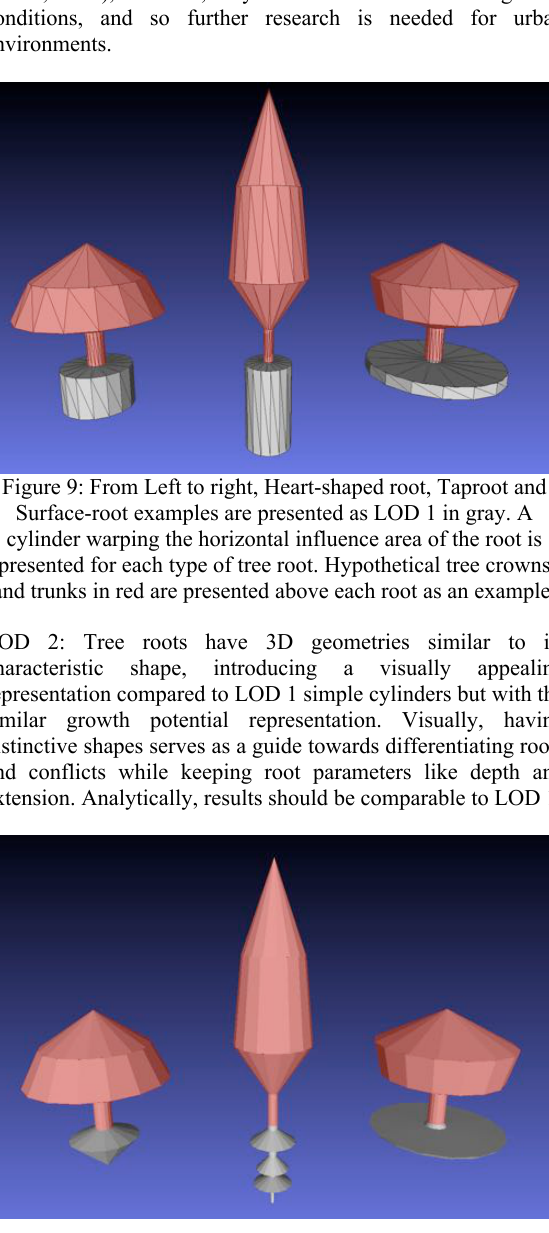
Figure 10: From left to right, Heart-shaped root, Taproot, and Surface-root examples are presented as LOD 2, expressing the type of root specific for each tree. A red tree in red is presented above each root as an